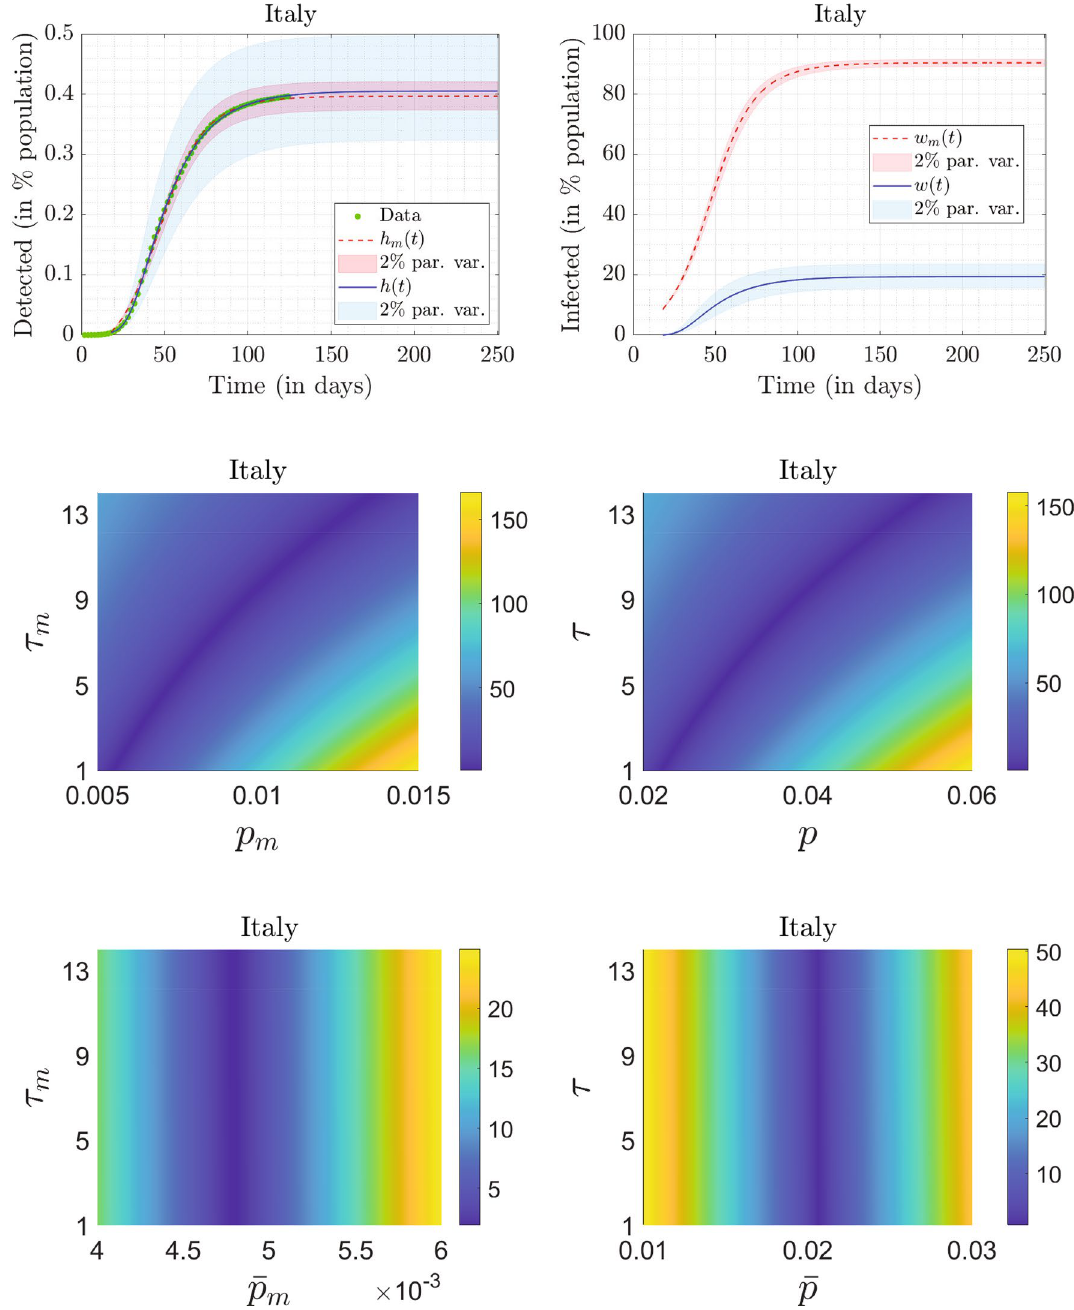
0.3966% and h ( 250 ) 0.4051% . Data in Figure 1. Top row, left panel: fitted results for Italy, h m ( 250 ) = = percentage of population for detected cases, obtained from Worldometer, is plotted using green circles. We have plotted the data of alternate days for clarity. The fit to the detected cases obtained using the mean- β model is shown by a dashed red curve, and that using the continuum model is shown by a solid blue curve. The parameters used in the mean- β model and continuum model for obtaining the fit are reported in row 1 of 2% variations in the parameters in Tables 3 and 4, respectively. The red and blue shaded bands correspond to ± the mean- β model and the continuum model, respectively. Top row, right panel: Percentage of infected people obtained from the mean- β model (dashed red curve) and the continuum model (solid blue curve), respectively; 2% variations 90.4331% and w ( 250 ) 19.4350% . The red and blue shaded bands correspond to w m ( 250 ) ± = = in the parameters in the mean- β and the continuum model, respectively. Middle row, left panel: Variation of E 0 m τ m plane (for low values of p m ) obtained using the mean- β model. The parameters β m and V 0 are in the p m − τ m plane. p m fixed at the values reported in row 1 of Table 3. Bottom row, left panel: Variation of E 0 m in the ¯ − τ plane (for low values of p ) obtained from the continuum Middle row, right panel: Variation of E 0 in the p − model. The parameters a , m , and f 0 are fixed at the values reported in row 1 of Table 4. Bottom row, right panel: τ p Variation of E 0 in the ¯ −